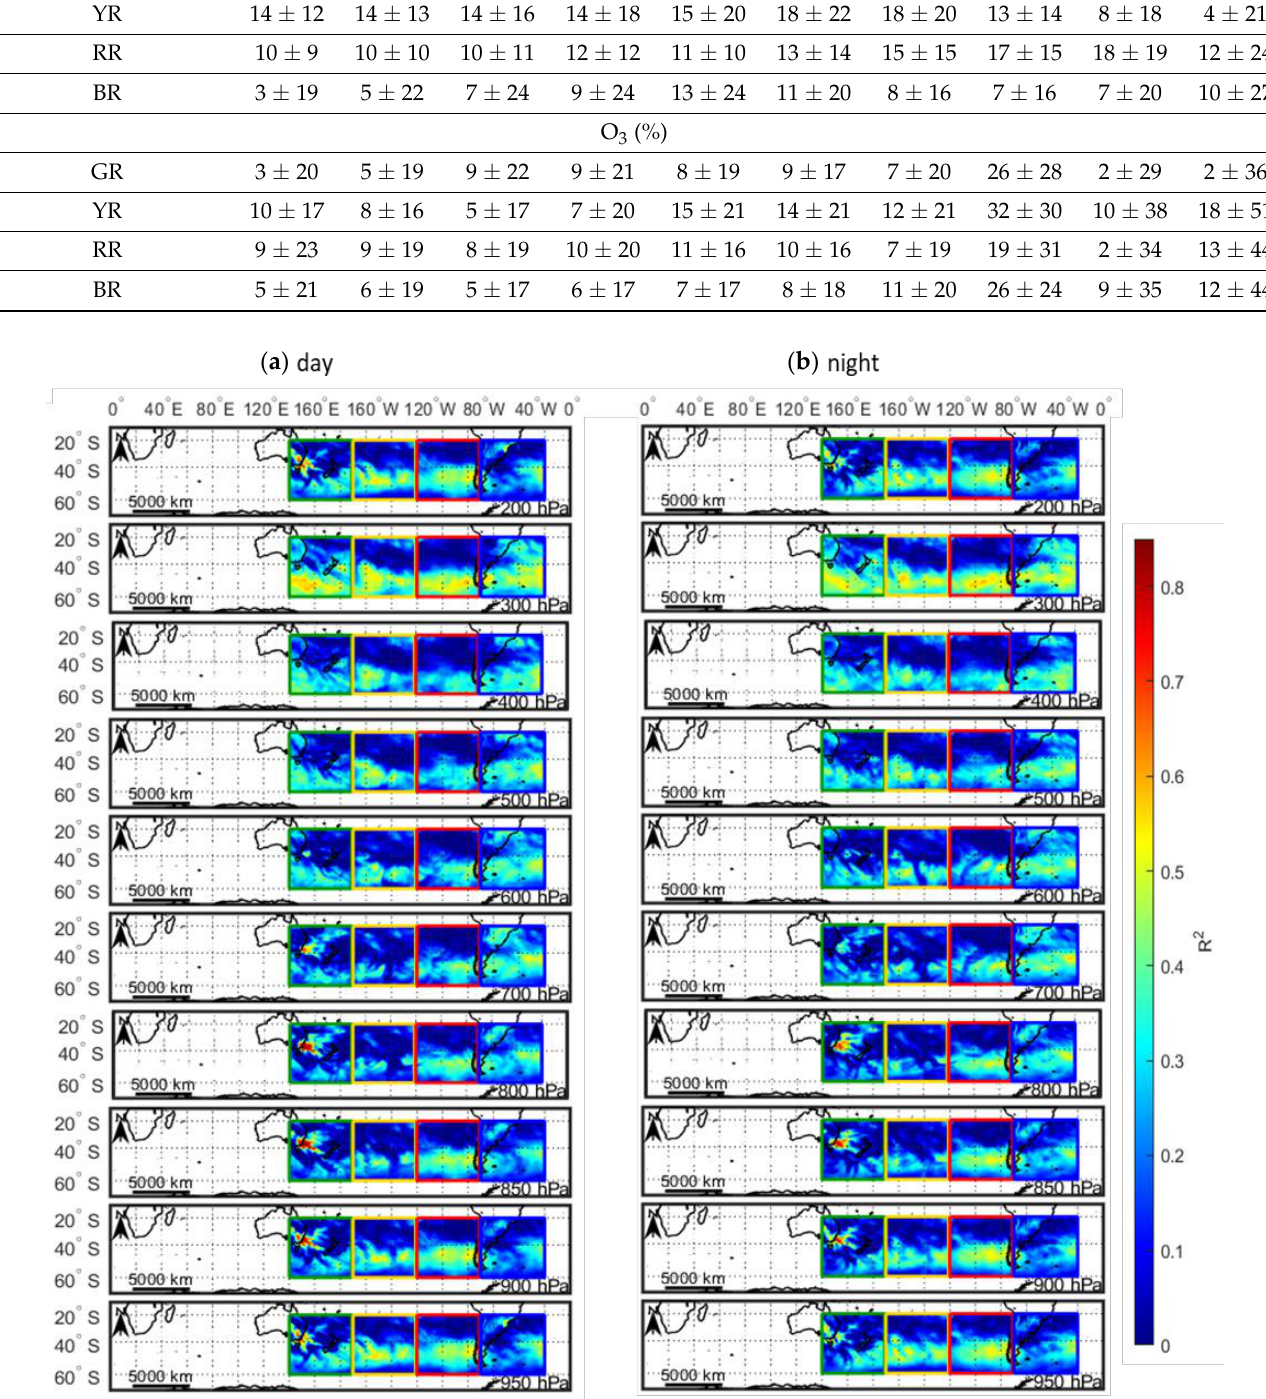
Figure A2. R 2 between CO and O 3 relative differences with respect to the base dataset at various pressure levels (950–200 hPa) ( a ) during day and ( b ) night.